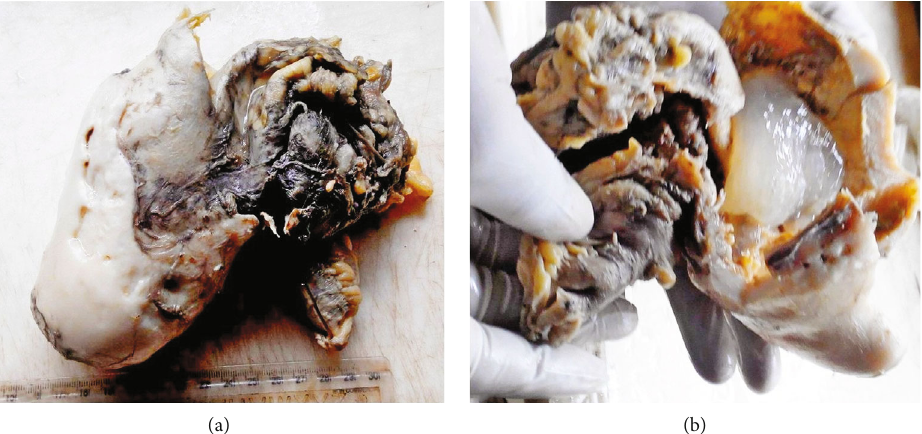
Figure 1: Gross photograph of low-grade appendiceal mucinous neoplasm. (a) It shows formalin- fi xed right hemicolectomy tissue consisting of segments of terminal ileum, ascending colon and fi rm cystic sclero-hyalinized appendiceal mucinous neoplasm. (b) The cut section of the appendiceal neoplasm hand-held to display the content of gelatinous mucin and the remarkably thick sclerotic wall.